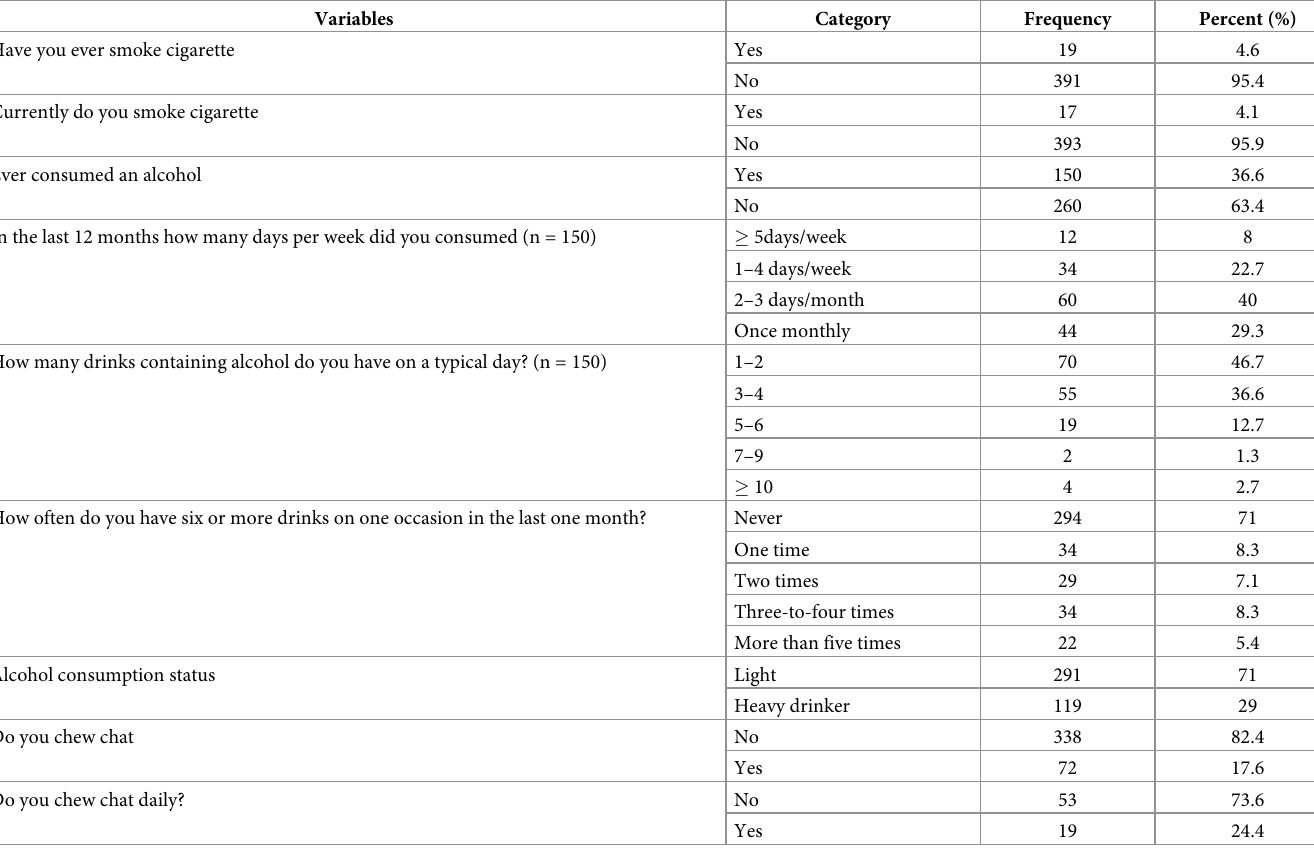
Table 2. Behavioral characteristics of the governmental employees in East Guji Zone, Southern Ethiopia, 2021.